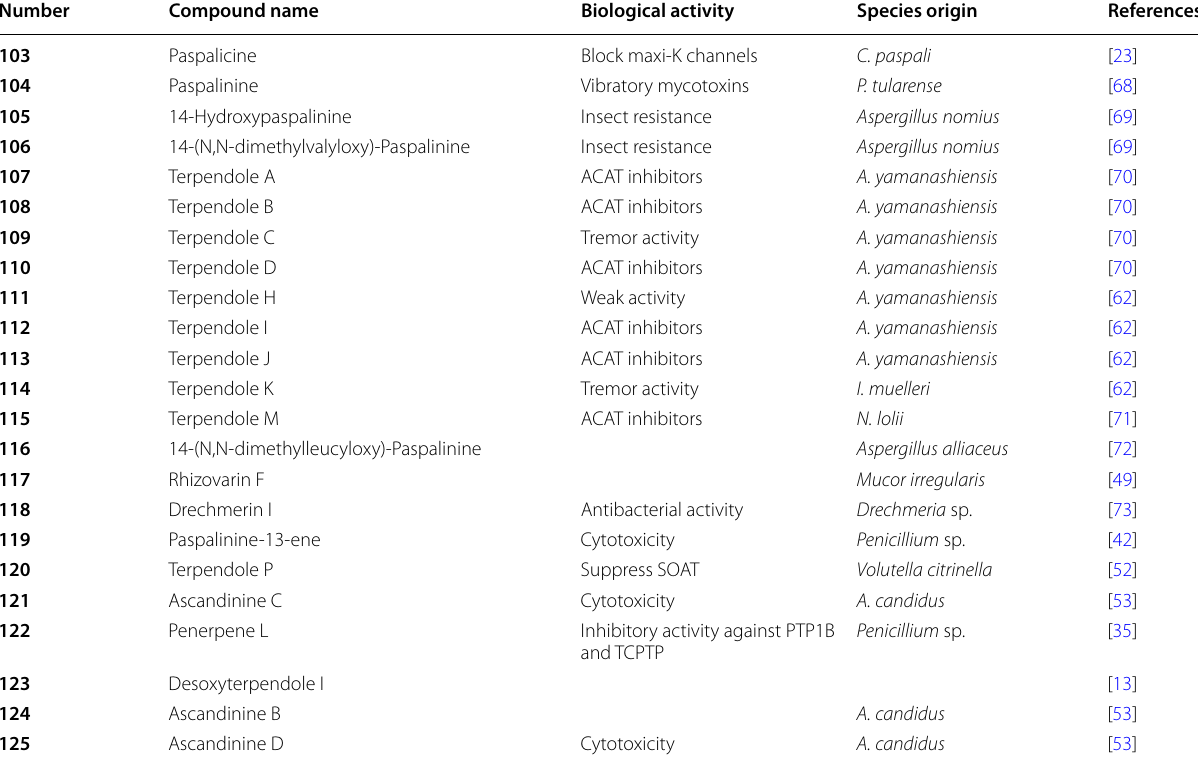
Table 8 Name, bioactivities and source of compounds with F‑ring